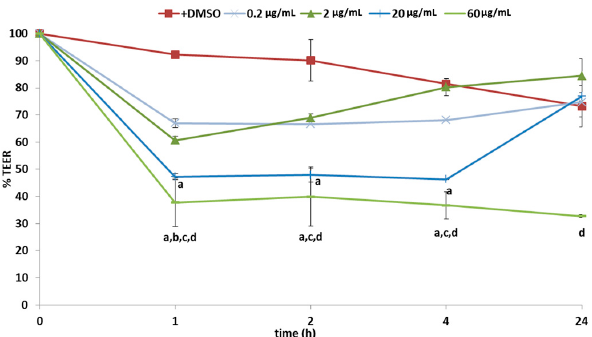
Figure 2. Effects of pure tomatine (P) on Caco-2 TEER values expressed as % relative to the control (DMEM + DMSO without tomatine). Values represent mean ± standard deviation of three different biological replications and two technical repetitions. Different superscript letters indicate statistically significant differences ( p < 0.05) in adhesion as assessed by one-way ANOVA test.